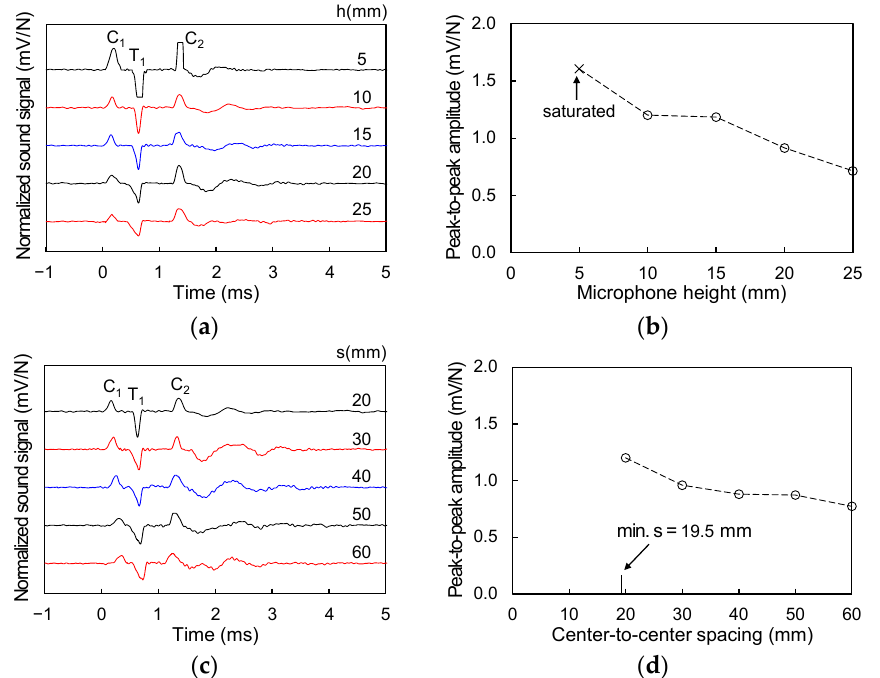
Figure 4. Optimal microphone height and center-to-center spacing between hammer and microphone: ( a ) measured sound waves for different height under fixed spacing (s = 20 mm); ( b ) normalized peak-to-peak amplitude under fixed spacing (s = 20 mm); ( c ) measured sound waves for different spacing under fixed height (h = 10 mm); and ( d ) normalized peak-to-peak amplitude under fixed height (h = 10 mm).